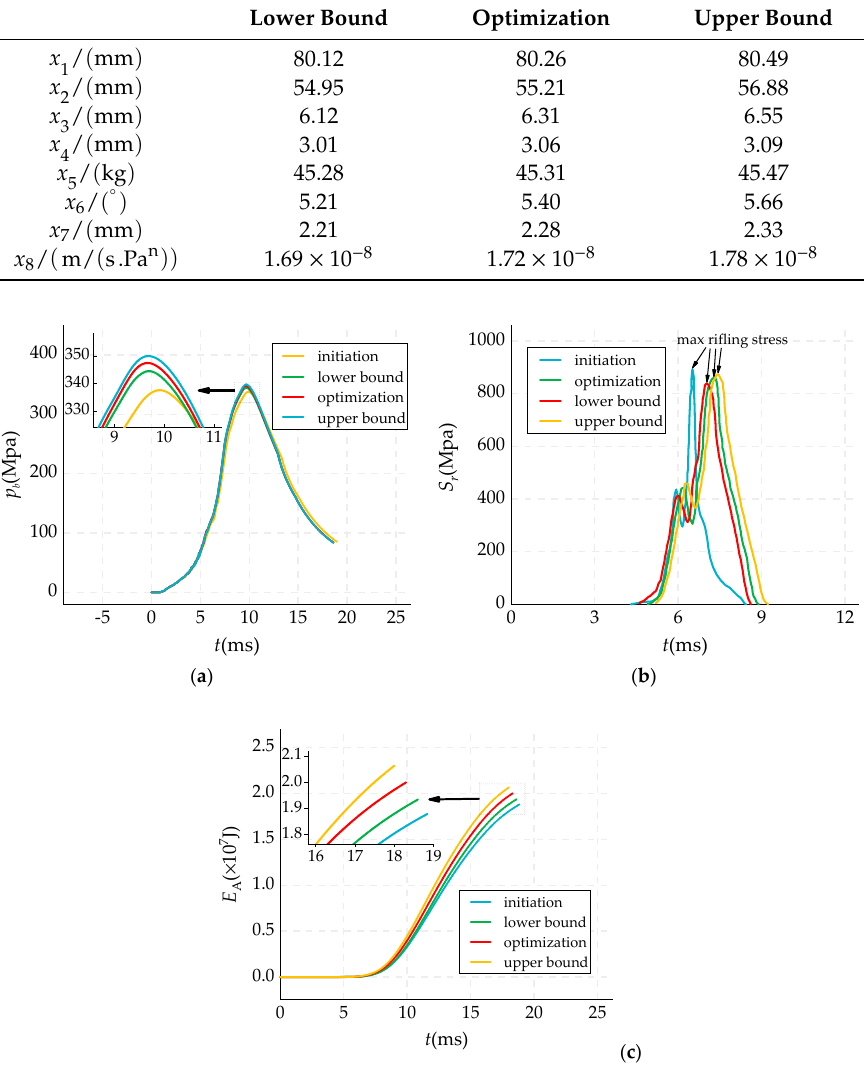
Table 6. The optimized intervals of design variables.